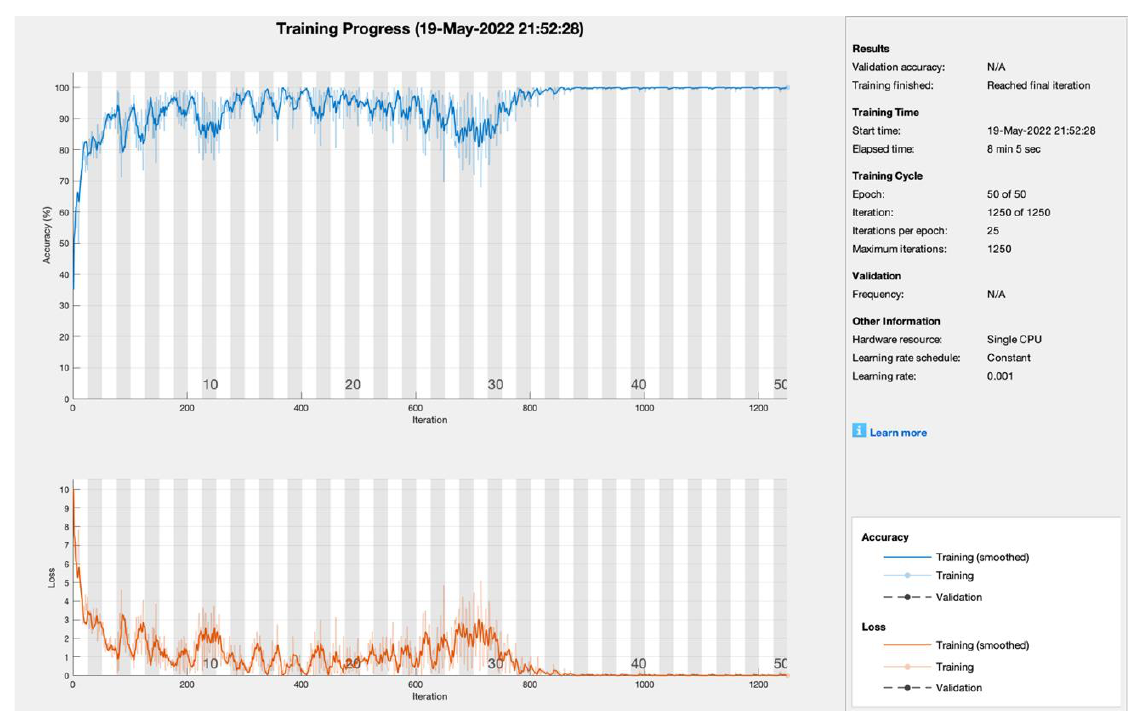
Figure 4. Training progress of ADAM empowered with blockchain, edge computing, and fog computing.